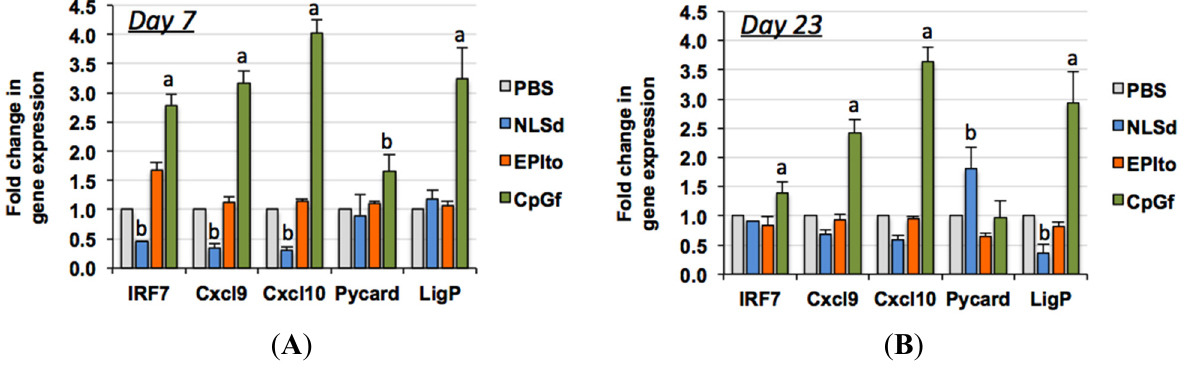
Figure 3. In vivo delivery of pEPIto in skeletal muscle promotes gene expression changes but these are consistent with a reduced inflammatory response by day 7 and day 23 post-delivery as compared to pCpG F control. ( A ) p < 0.05 relative to all other groups; ( B ) p < 0.05 relative to phosphate-buffered saline control (PBS)